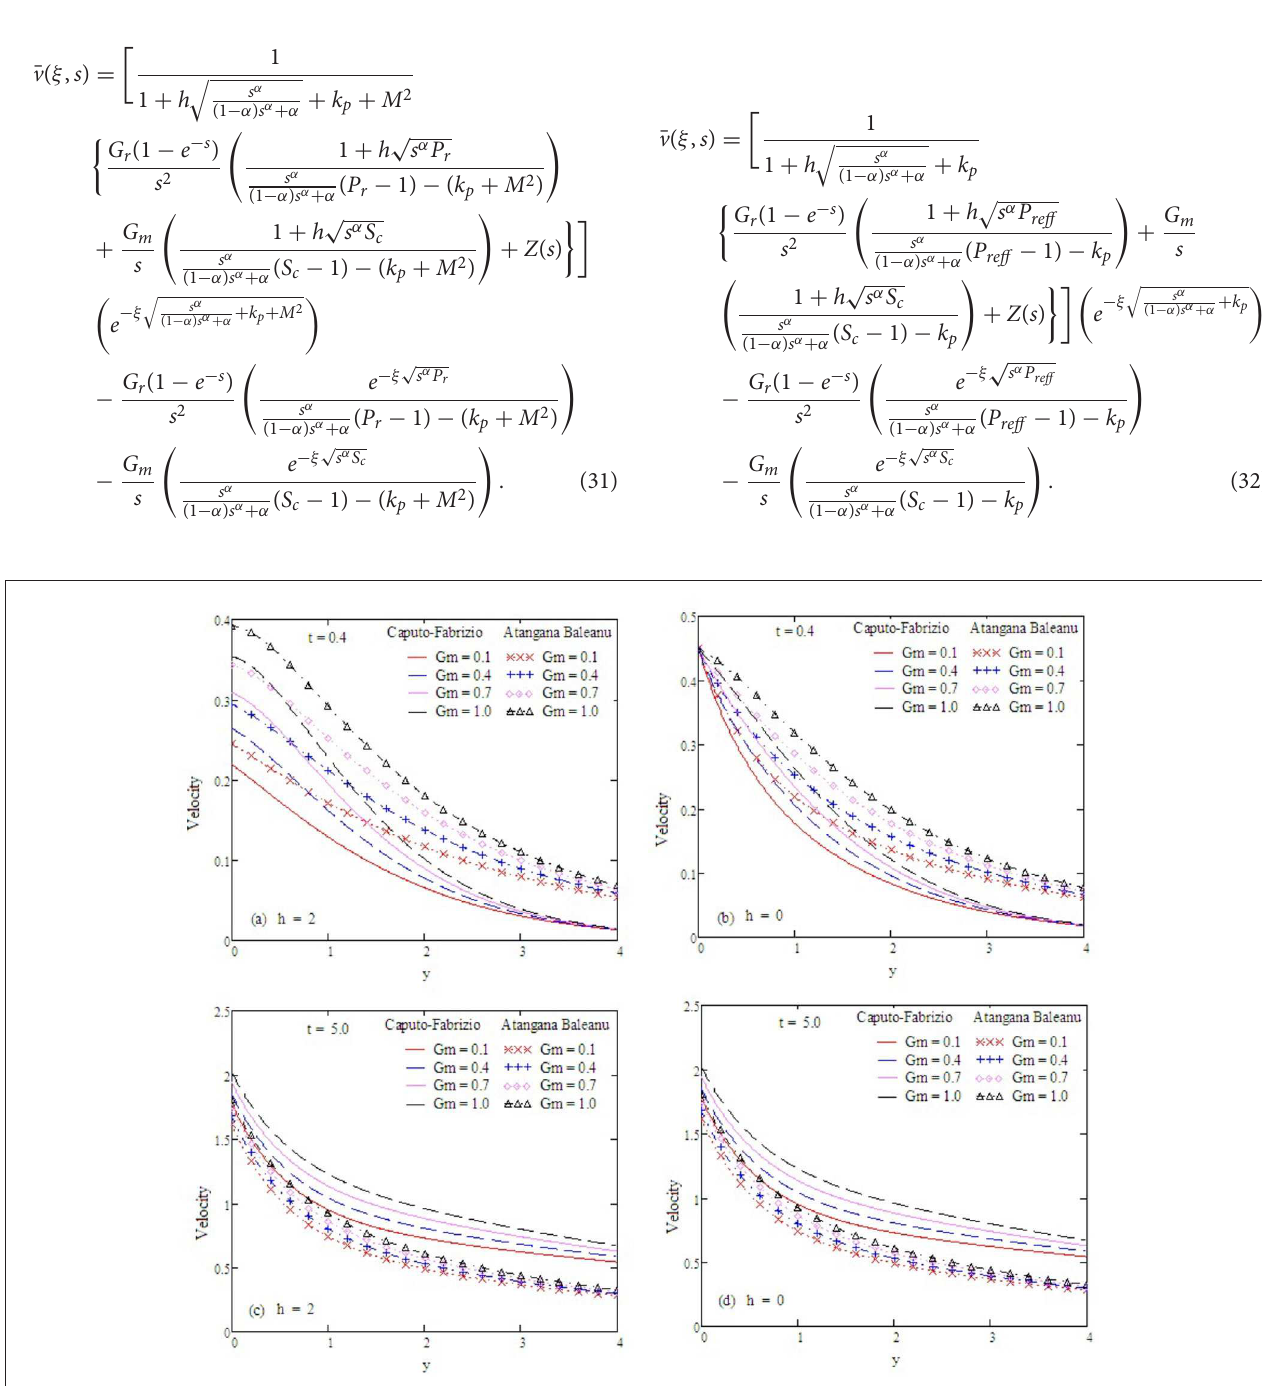
FIGURE 7 | Velocity profiles with altered values of G m and other parameters are α